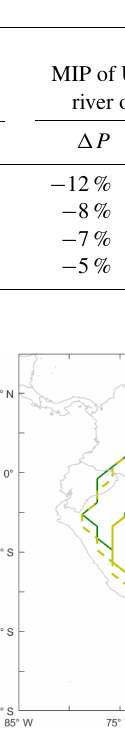
Figure 3. The precipitationshed of the sensitive areas. The contour value stands for the fraction of rainfall from continental evapotran- spiration in sensitive areas that is evapotranspirated from the de- limited region collectively. The first contour delimits areas (shown in dark blue) corresponding to the most influential precipitation- shed (MIP) for the sensitive regions (represented by yellow cells). A total of 74.7% of the sensitive areas’ total rainfall comes from con- tinental evapotranspiration. Of this, 40% originates from the MIP.